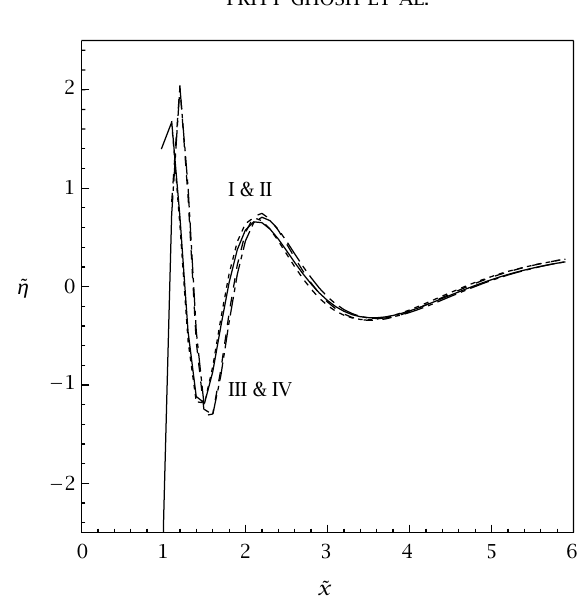
Figure 5.1 . Wave profiles due to an initial disturbance in the form of an initial depression ( ˜ t = 8 . 0 ) , (cid:5)/h = 0 . 01, N 2 h/g = 0 . 1 I; (cid:5)/h = 0 . 01, N 2 h/g = 0 . 0 II; (cid:5)/h = 0 . 0, N 2 h/g = 0 . 1 III; (cid:5)/h = 0 . 0, N 2 h/g = 0 . 0 IV.